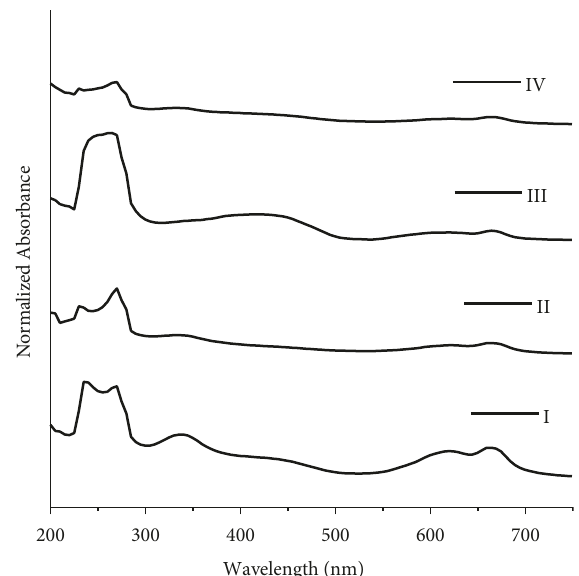
Figure 4: UV/Vis spectra for groups I, II, III, and IV of green ballpoint pen inks.